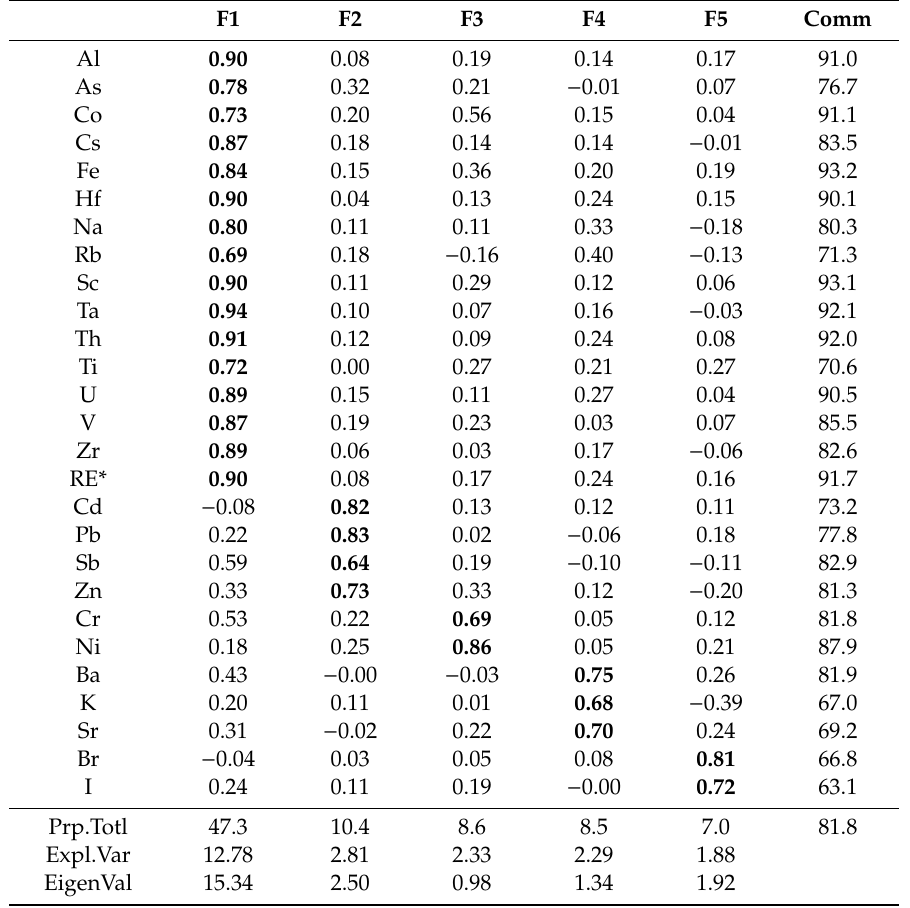
Table 3. Matrix of dominant rotated factor loadings normal values ( n = 216, 27 selected